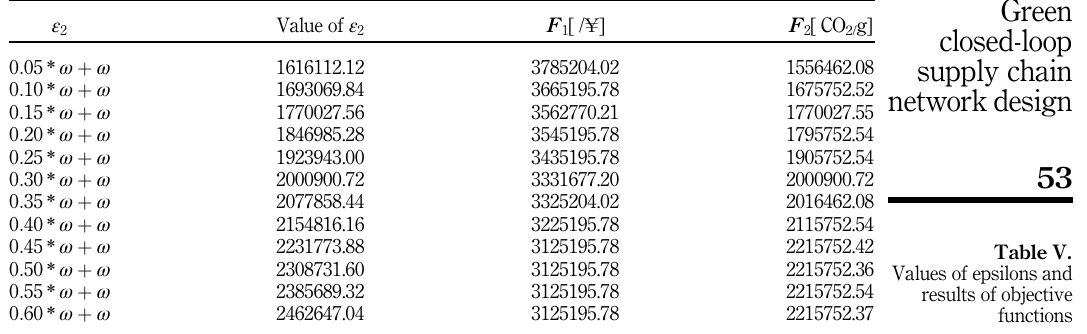
Table V. Values of epsilons and results of objective functions